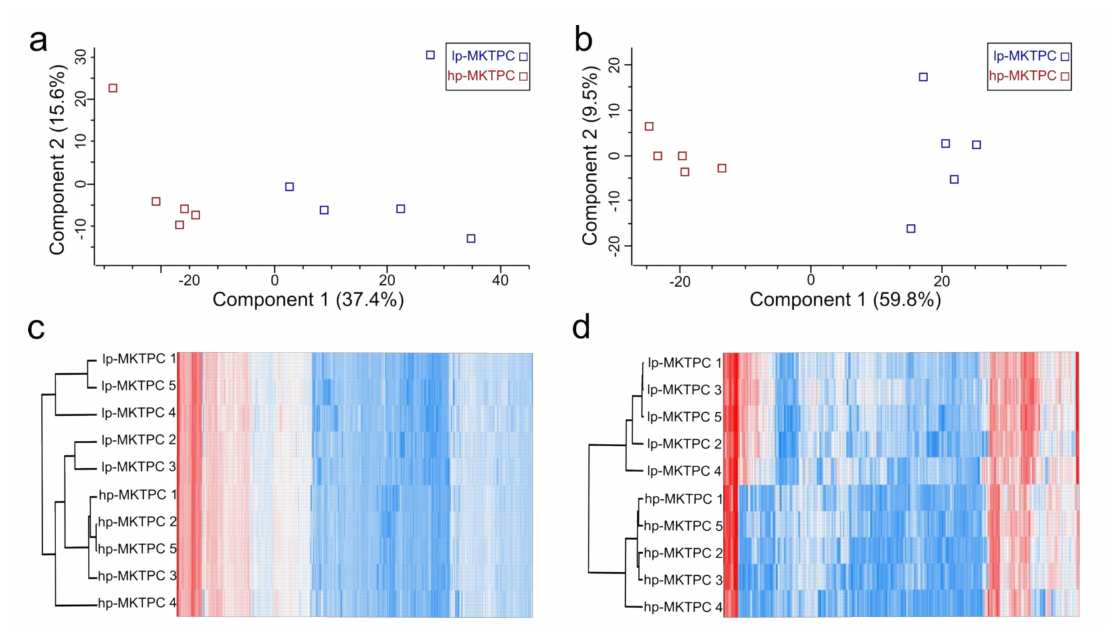
Figure 2. Principal component analysis (PCA) of cellular proteomes ( a ) and secretomes ( b ) of MKTPCs derived from lp-MKTPCs and hp-MKTPCs; each square represents an individual donor. Heat map and unsupervised hierarchical clustering of cellular proteomes ( c ) and secretome ( d